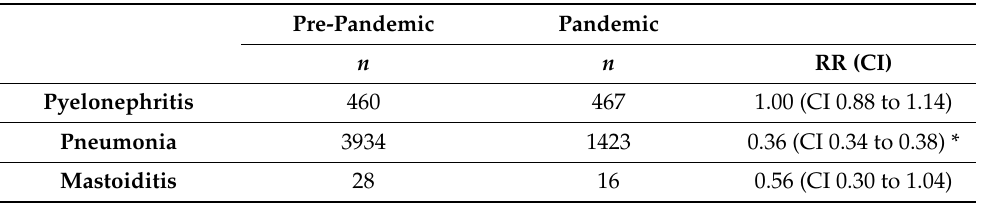
Table 4. Numbers of registered diagnoses indicating complications pre-pandemic and during the first pandemic